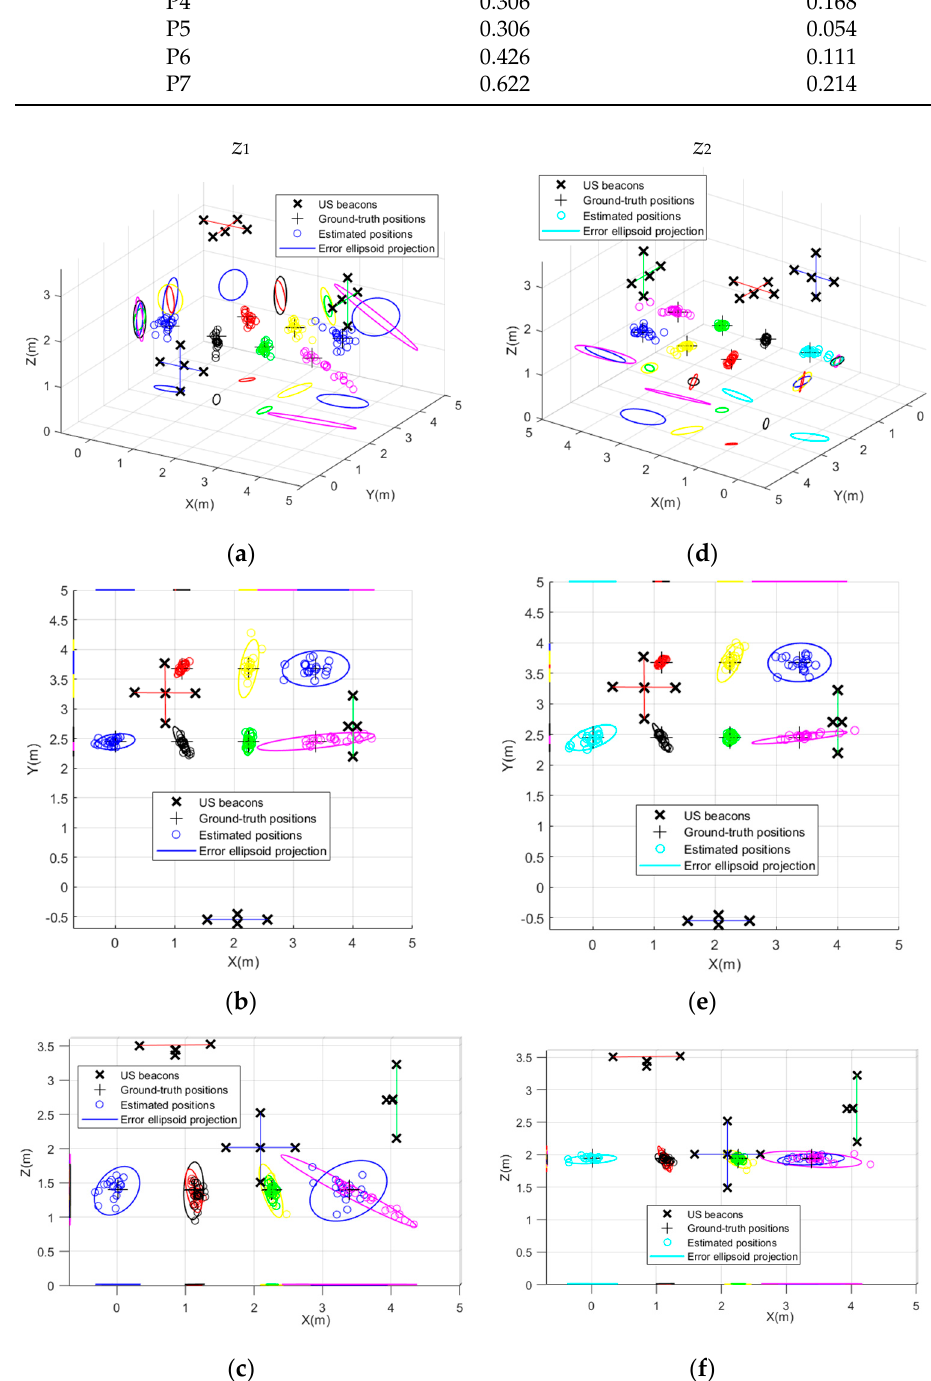
Figure 9. Estimated positions after AKF fusion for the points P1–P7, including the projections of their corresponding error ellipsoids with a certainty of 95% in the XY and XZ planes, at z 1 = 1.35 m (left) and z 2 = 1.93 m (right): successively, 3D representation of clouds of points; Y–X projections; and Z–X projections. and Z–X